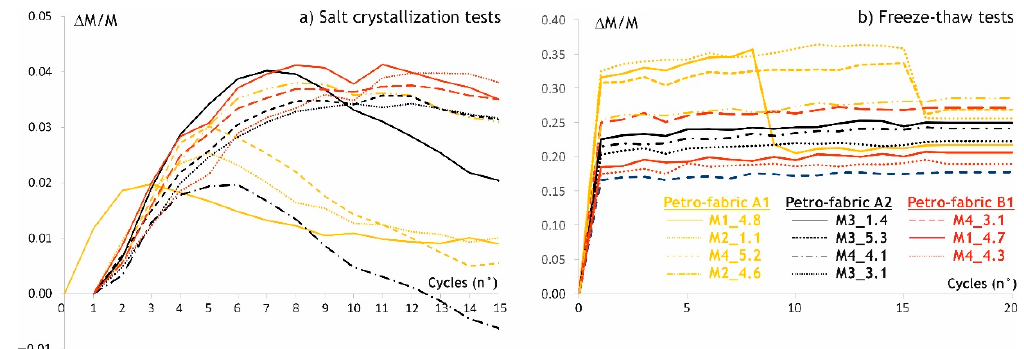
Figure 12. Variation of weight in bricks belonging to petro-fabrics A1, A2 and B1 during durability tests. ( a ) Salt crystallization and ( b ) Freeze-thaw. Weight variation ( ∆ M/M) versus time (in number of cycles, each cycle corresponds to 24 h). Each curve represents the mean of two measurements.